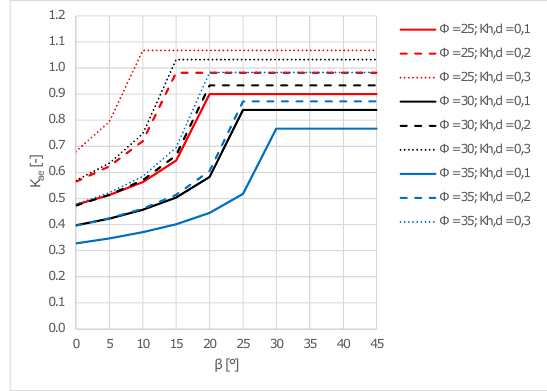
Figure 3. Dependence of the inclination of the terrain behind the wall and the coefficient K ae according